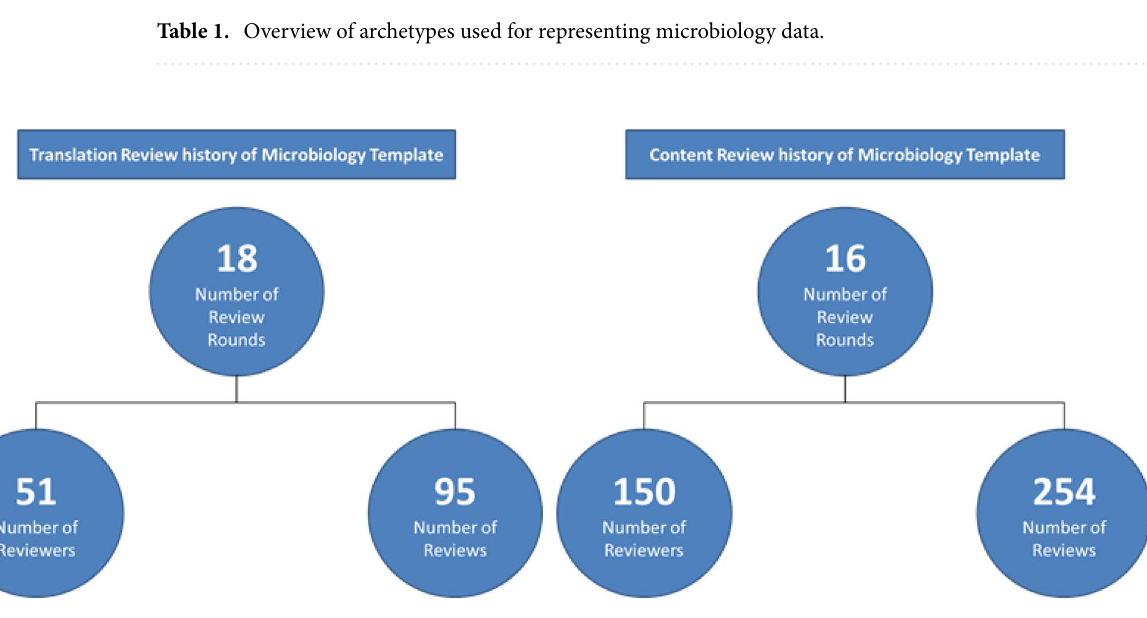
Figure 2. Review history of microbiology